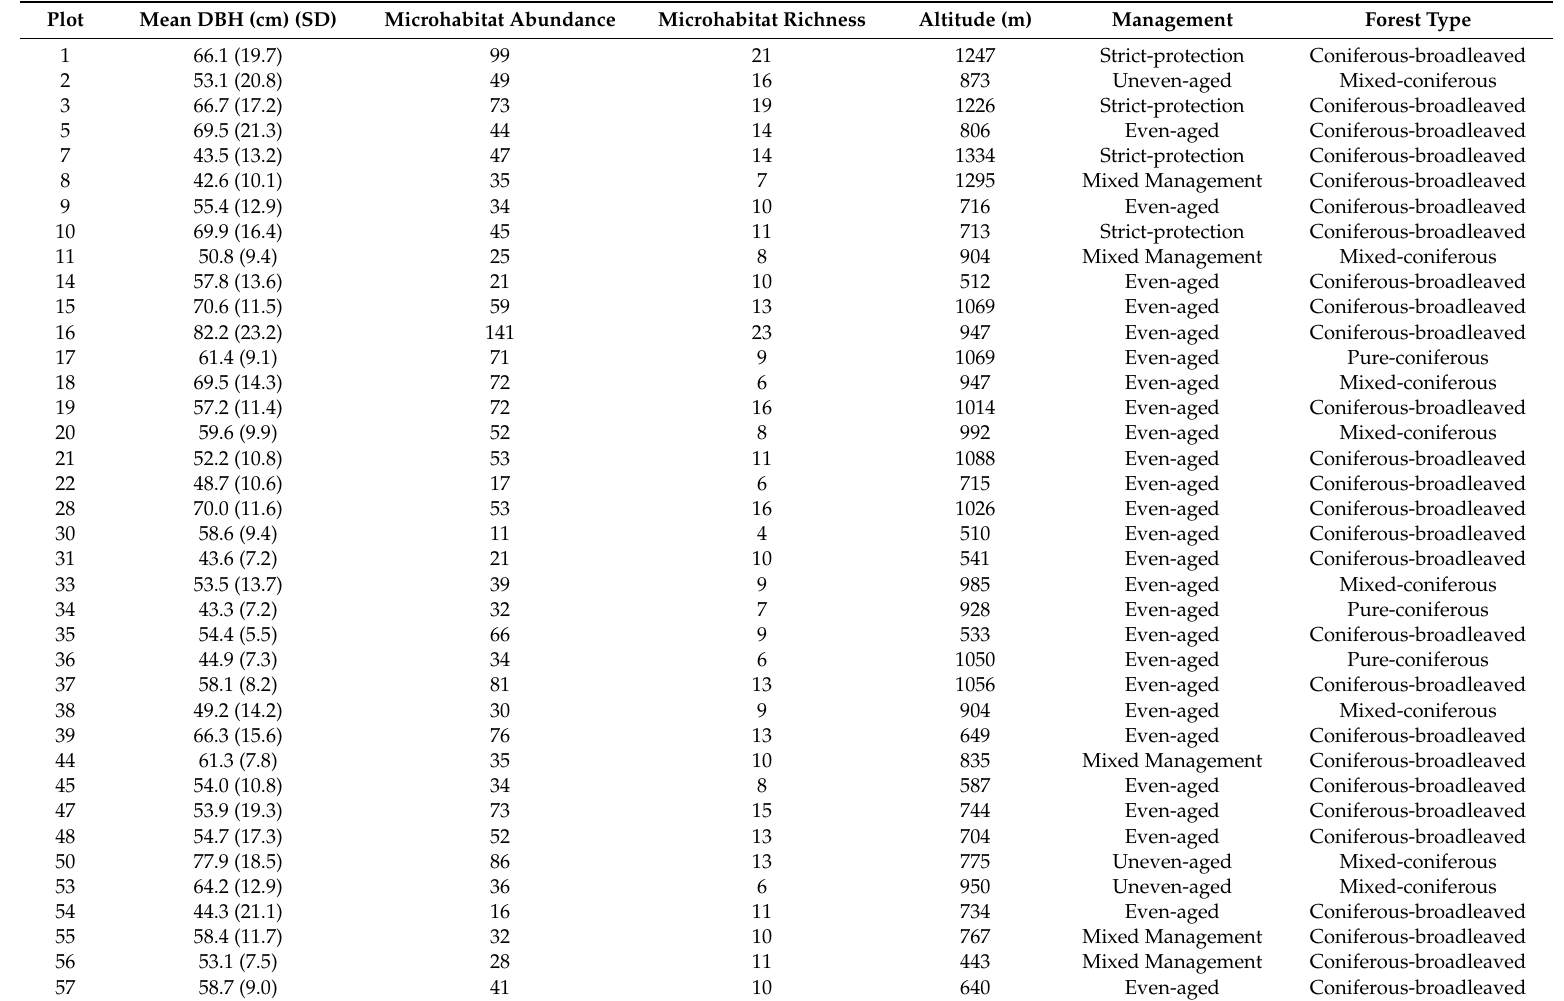
Table A2. Overview of the plots inventoried including DBH, microhabitat abundance and richness, altitude, management type as well as forest type.